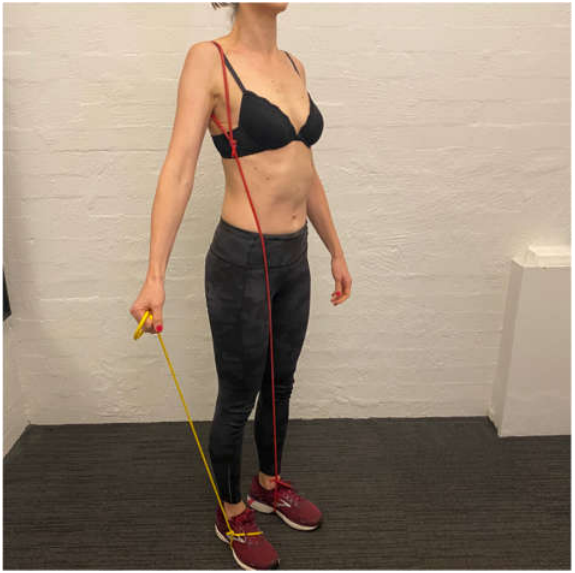
Figure 5. Resistance band under foot during scapula upward rotation/elevation